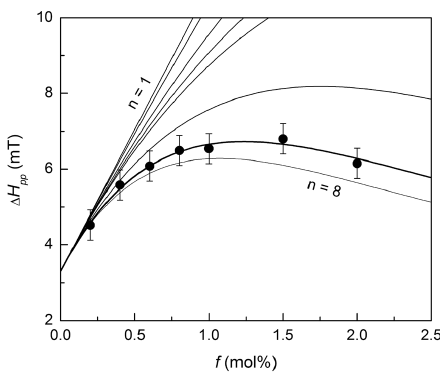
sample doped with 0.6 mol% Gd. 3